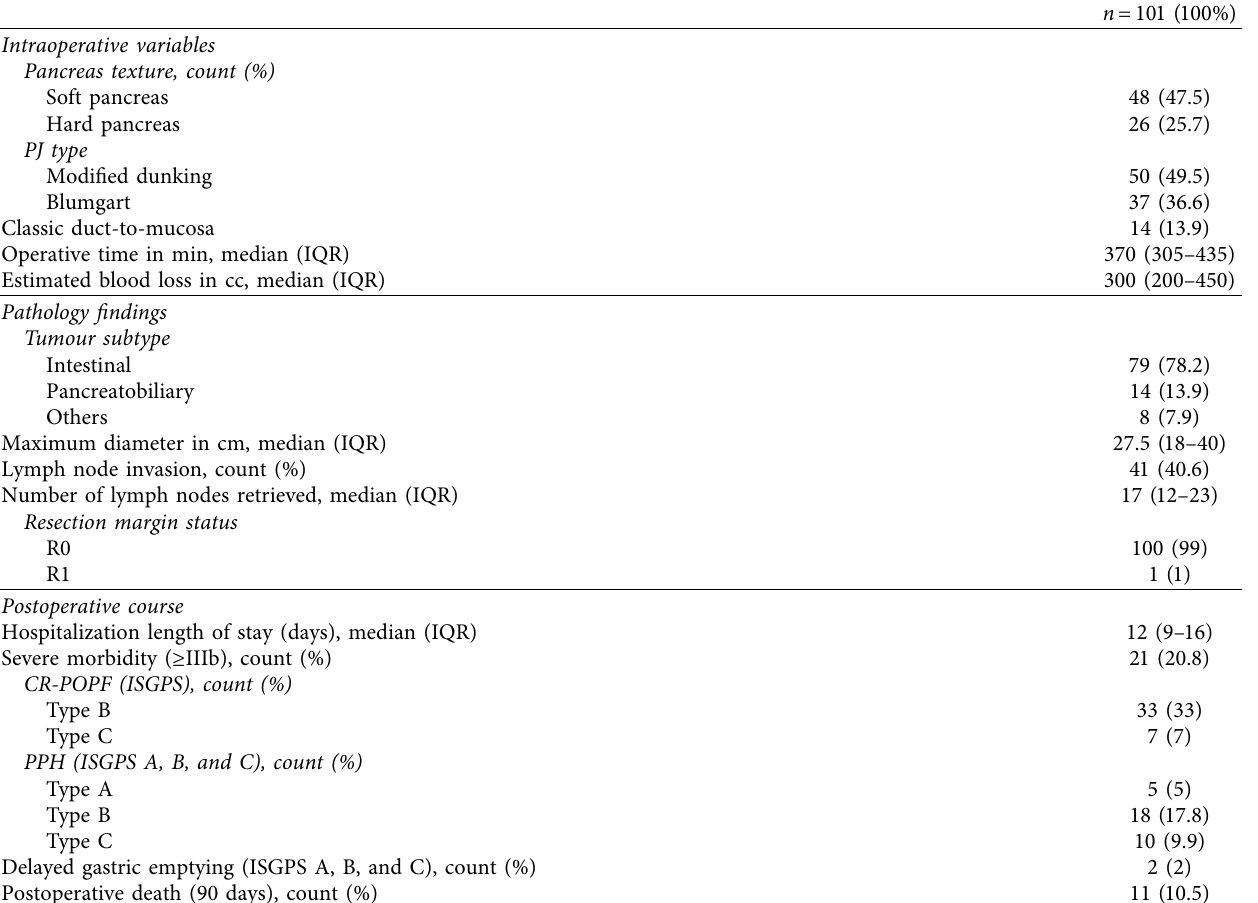
Table 2: Operative and pathologic patient characteristics.